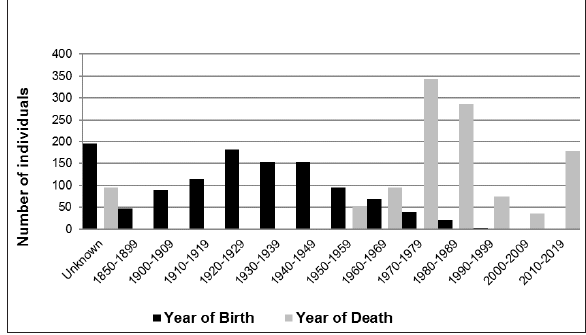
Figure 2: Frequency distributions for year of birth and year of death for the skeletons in the Kirsten Skeletal Collection. The collection comprises individuals from three main socially defined population groups, namely South African coloured (59.7%), South African black (16.5%) and South African white (12.2%). The regional population composition of the Western Cape Province differs considerably from that of other provinces in South Africa. According to the census of 2011 7 , the black population group has the highest proportion (of over 79%) in all provinces with the exception of the Western Cape (32.9%). The South African coloured population is the highest proportion in the Western Cape (48.8%). Therefore, it is expected that a larger South African coloured population is apparent in the Kirsten Skeletal Collection, which is derived mainly from Western Cape individuals. However, the South African coloured population in the Western Cape declined from 58.3% in 1991 24 to 48.8% in 2011 7 . Cadavers were mostly acquired from the large teaching hospitals in the region, namely Tygerberg Hospital (32%), followed by Karl Bremer Hospital (10.1%), both in the Bellville area, and Groote Schuur Hospital (6.8%) in Cape Town. A total of 15.6% of individuals were received directly from undertakers as paupers and 14.6% were from unknown sources or sources that had not been documented (Table 2). Available records for the last residence of individuals in the Kirsten Skeletal Collection indicate that the greatest proportion were from the Cape Town metropole (42.3%) and surrounding towns (19.1%) (Table 3).